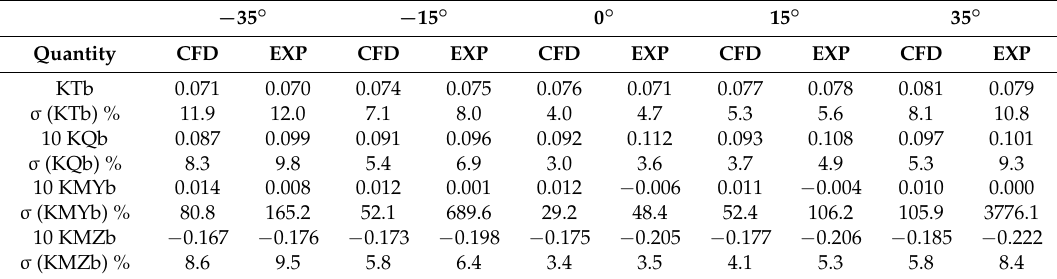
Table 5. Measured and computed single blade loads at J = 0.3 for different heading